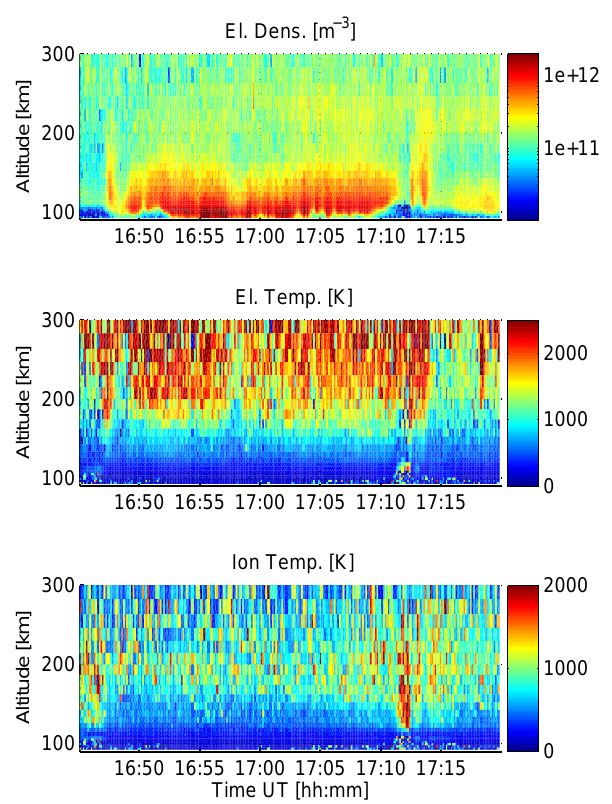
Fig. 1. Overview of the radar data for the event on 12 Decem- ber 2006. The three panels show electron density, electron temper- ature and ion temperature